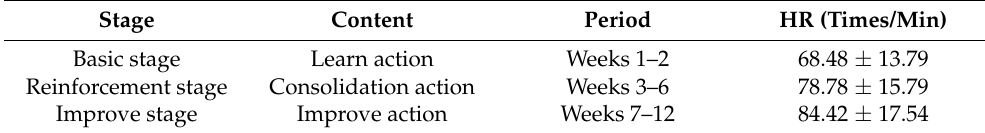
Table 3. Exercise Load Control in CTG (heart